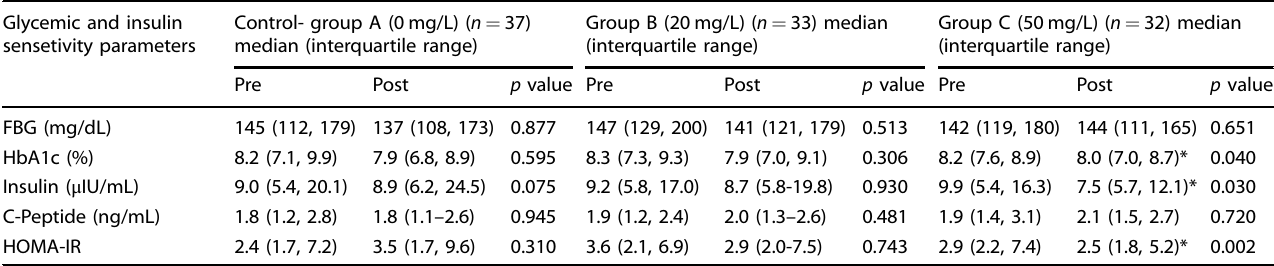
Table 2. Effect of different doses of magnesium chloride added to the desalinated water on glycemic and insulin sensitivity parameters. Glycemic and insulin sensetivity parameters